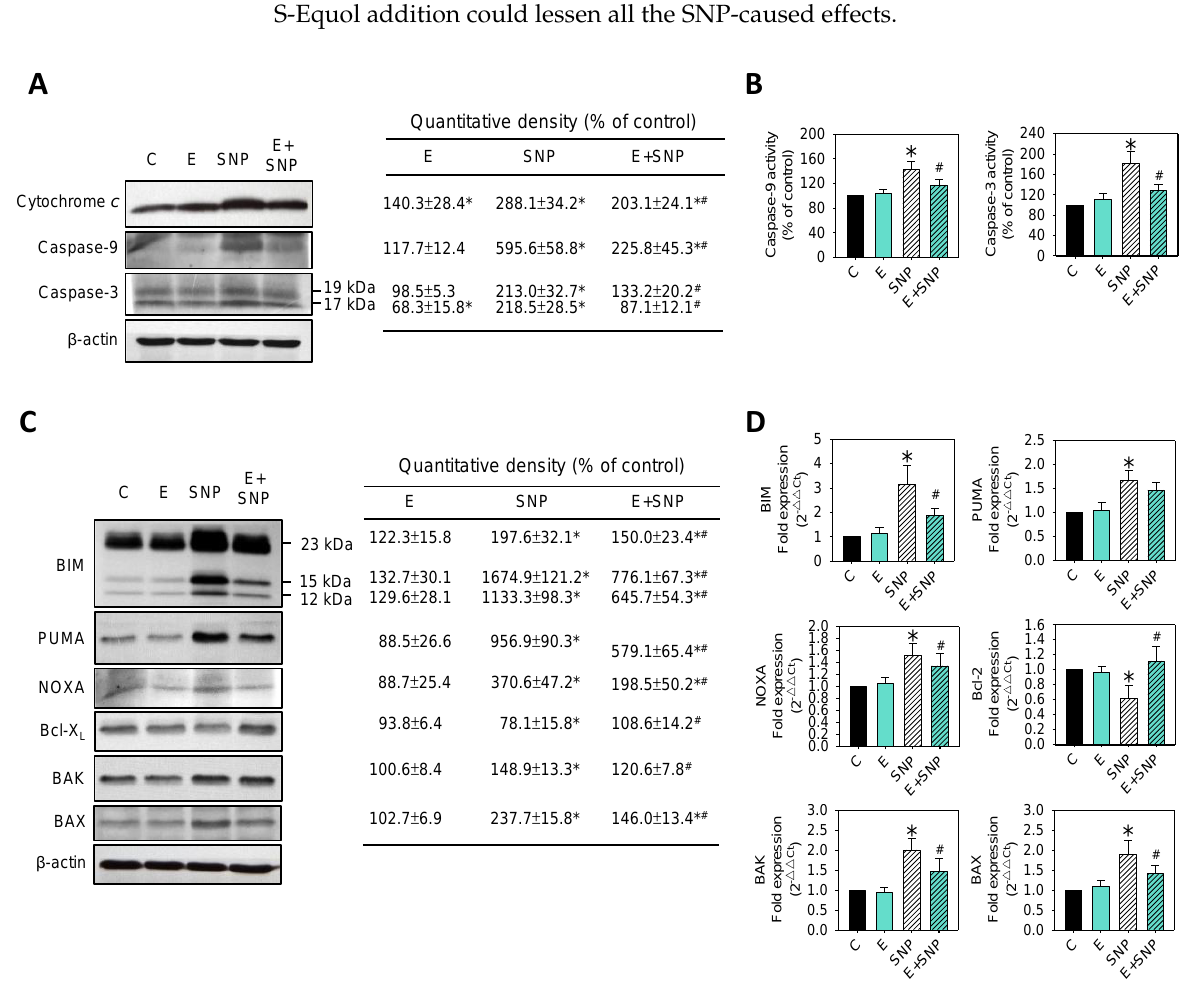
Figure 4. The effect of SNP and/or S-Equol on expressions of apoptotic and anti-apoptotic proteins of primary chondrocytes. After cells were treated with S-Equol for 24 h in the presence or absence of SNP for another 24 h, ( A ) cytochrome c , caspase-9, and caspase-3 levels were measured by Western blotting. β -actin was used as the internal control. The data in the right panel are expressed as the relative density compared to the untreated cells (control), which was 100%; ( B ) caspase-9 and caspase-3 activity were measured by a colorimetric assay; ( C ) BIM, PUMA, NOXA, Bcl-X L , BAK, and BAX protein levels were measured by Western blotting; and ( D ) BIM, PUMA, NOXA, Bcl-2, BAK, and BAX mRNA levels were measured by real-time PCR. β -actin was used as the internal control. The data are expressed as fold changes compared to that in untreated control, which was 100%. The results are the mean ± S.D. for three separate experiments. * p < 0.05 compared to the corresponding untreated control. # p < 0.05 compared to the corresponding SNP treated group.